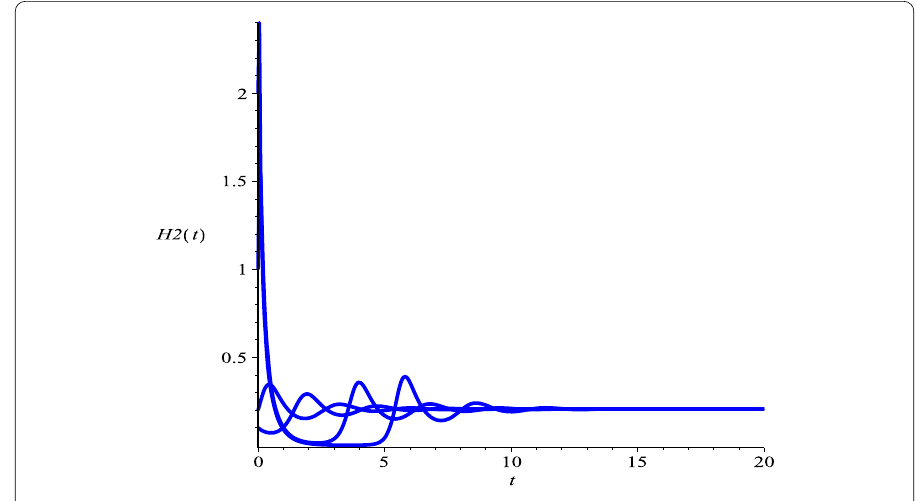
Figure 8 Dynamic behaviors of the weak partners in system (5.6). The initial conditions ( H